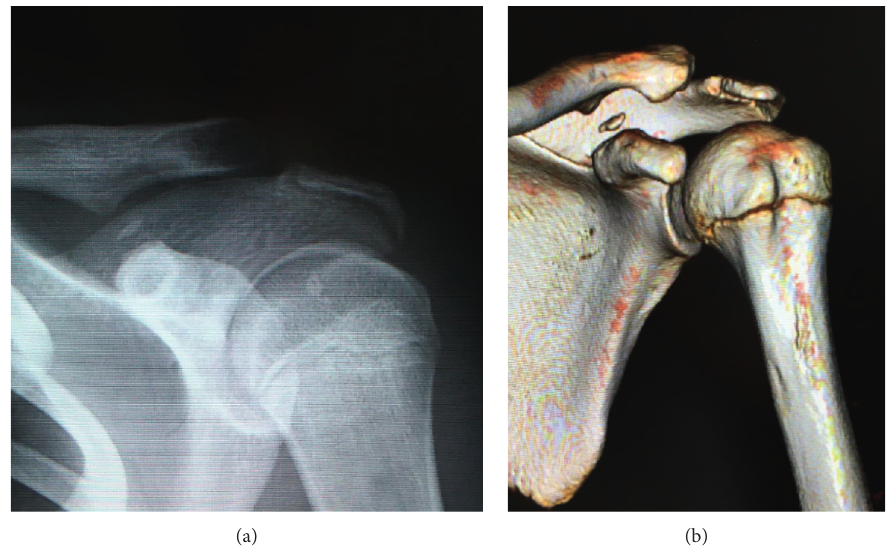
Figure 3: Representative anteroposterior radiograph of case 9: three-dimensional computed tomography reconstruction (a) and type II injury with an associated acromioclavicular dislocation